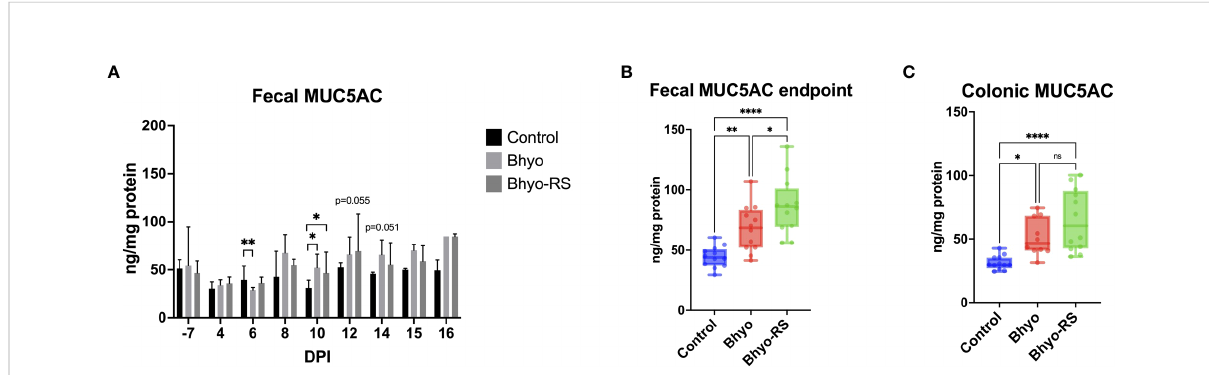
FIGURE 7 Signi fi cant differences in fecal MUC5AC concentration measured by ELISA was found on DPI 6 ( A , P < 0.05, ANOVA) and DPI 10 ( A , P < 0.05, Kruskal-Wallis). On DPI 12 (P=0.055, Kruskal-Wallis) and DPI 14 ( P = 0.051, Kruskal-Wallis), there was a trend of an overall difference between groups. The two inoculated groups had signi fi cantly higher fecal MUC5AC concentrations than the controls on DPI 10 (A, P < 0.05, Dunn ’ s). When comparing the endpoint fecal MUC5AC and colonic MUC5AC concentrations, the two inoculated groups have signi fi cantly increased endpoint fecal MUCAC and colonic MUC5AC concentrations ( B, C , P < 0.05, Tukey ’ s) compared to the controls. Fecal MUC5AC concentrations from the Bhyo-RS group were higher than the Bhyo group ( B , P < 0.05, Tukey ’ s). There was weak to no correlation found between fecal MUC5AC (ELISA), colonic MUC5AC (ELISA) concentrations, and immunohistochemical MUC5AC expression on the colonic tissues. *, P ≤ 0.05; **, P ≤ 0.01; ****, P ≤ 0.0001; ns, not signi fi